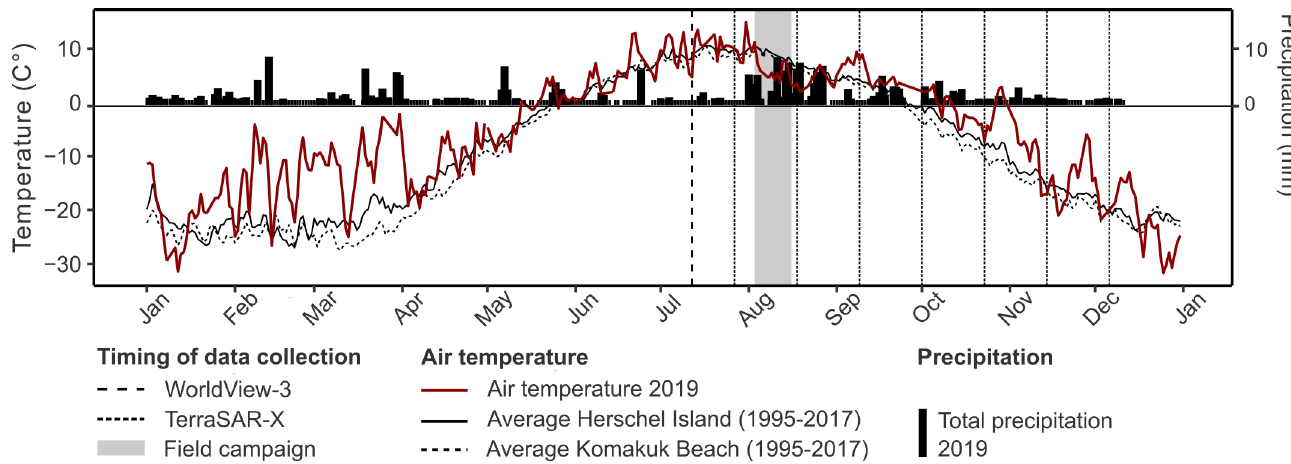
Figure 2. The mean daily air temperature (red line) and total daily precipitation (black bars) for 2019. The average daily air temperature for the period 1995 till 2017 (Herschel Island station, black line; Komakuk Beach station, gray